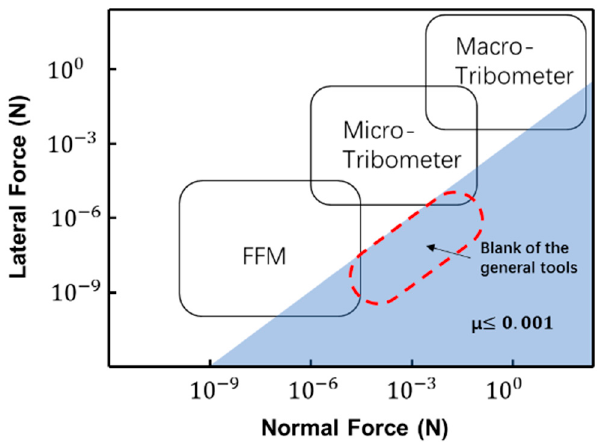
Figure 1. Summary of the current commercial instruments for tribology studies. The shade shows the requirements of forces in SSL studies. Force ranges of the instruments are enclosed in the rounded squares. There is a blank of the general tools which is circled by the dotted line.